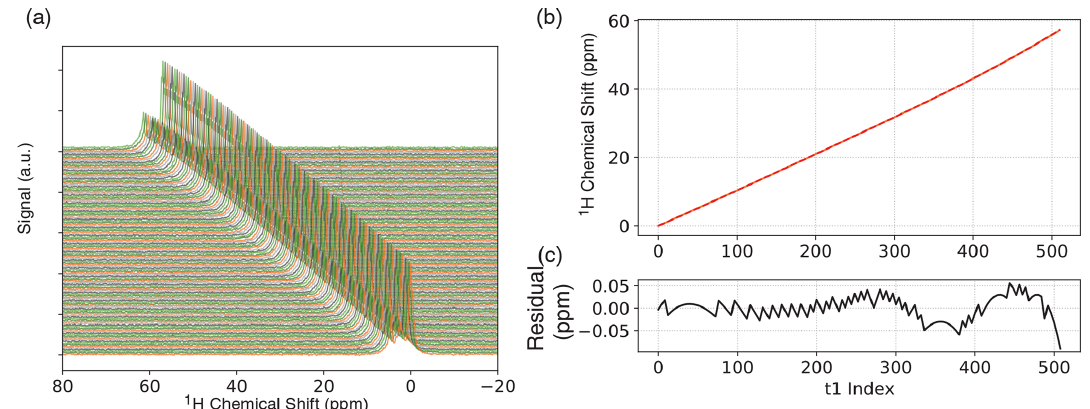
Figure 2. (a) One-dimensional ODNP-enhanced ethyl crotonate reference spectra with 10mM TEMPONE acquired after each completed phase cycle step of JRES experiment. Spectra are vertically offset for clarity. (b) Chemical shift of the peak with the maximum intensity and fit (fourth-order polynomial) for experimental drift correction. (c) Residual of the fit.